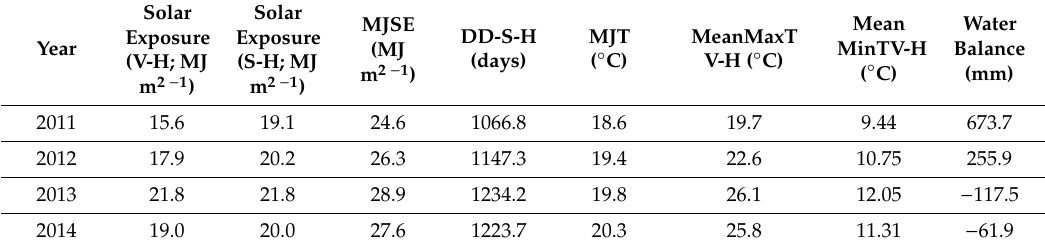
Table 1. Mean values of weather data only for the contrasting vintages based on water